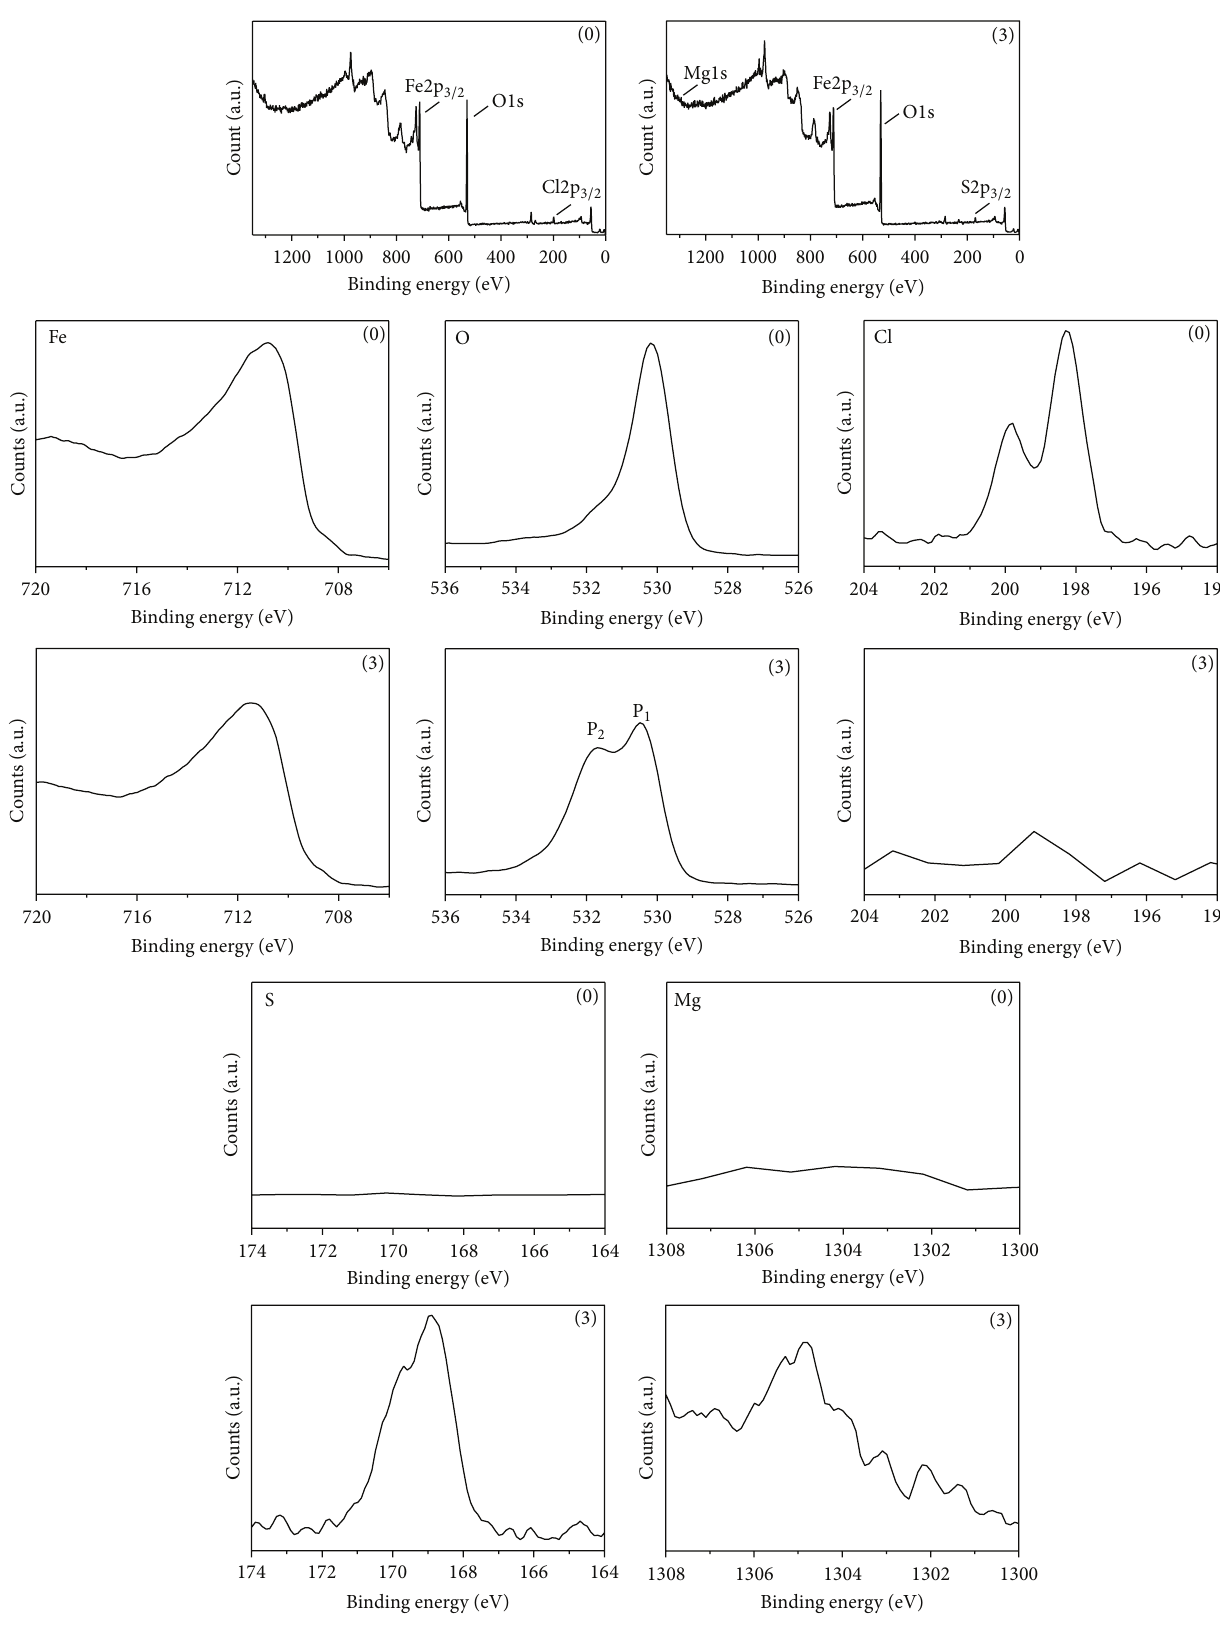
Figure 4: XPS spectra for samples ( 0 ) and ( 3